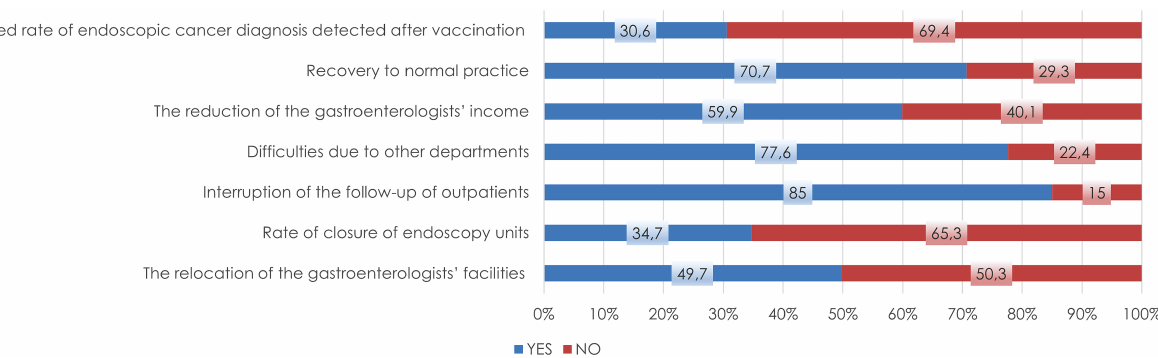
Figure 1. The effect of the pandemic on the practice of gastroenterology.